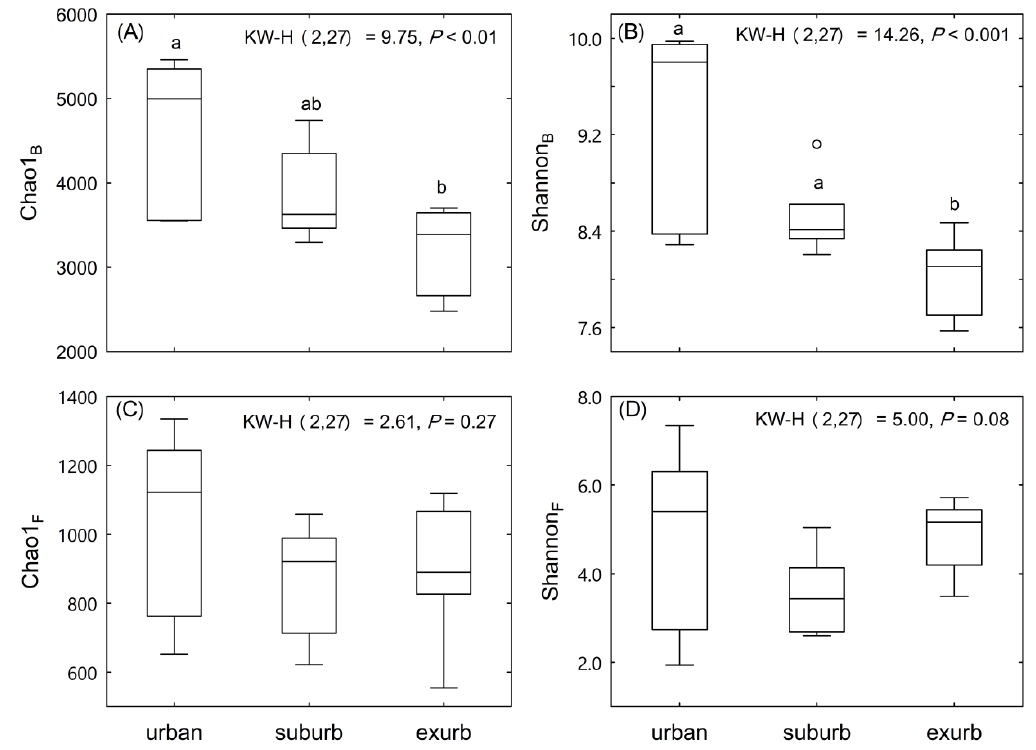
Figure 3. Diversity of soil bacterial community ( A , B ) and soil fungal community ( C , D ) along the